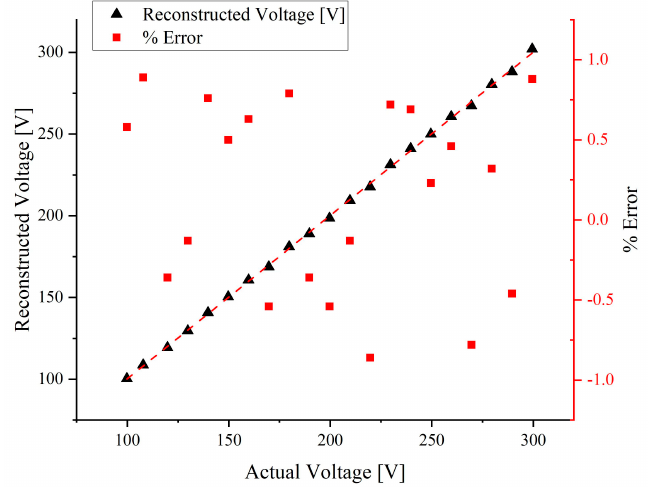
Figure 14. Error characteristics of the actual output voltage versus the probe output. As can be seen from Figure 14 and Table 6, the maximum error between the recon- structed voltage and the actual voltage amplitude is 0.89% when measured at 50 Hz. 4.4. High Voltage Amplitude Accuracy Test The high-voltage amplitude accuracy test was performed on a 3-m-high experi- mental platform by adjusting the output voltage through a transformer to increase the output range from 600 V to 10 kV. At each step, the observed signal output from the os- cilloscope and the calibrated value output from the multimeter were recorded. The recon- structed voltage with the maximum error was tallied. Table 7 shows the output voltage measured from the oscilloscope and the actual voltage output calibrated from the multi- meter for each step, this is when using the output voltage from a 50 Hz supply, as well as the maximum measurement error at the time of comparison that was tallied. Table 7. Reconfiguration voltage and error. Actual Voltage(V)